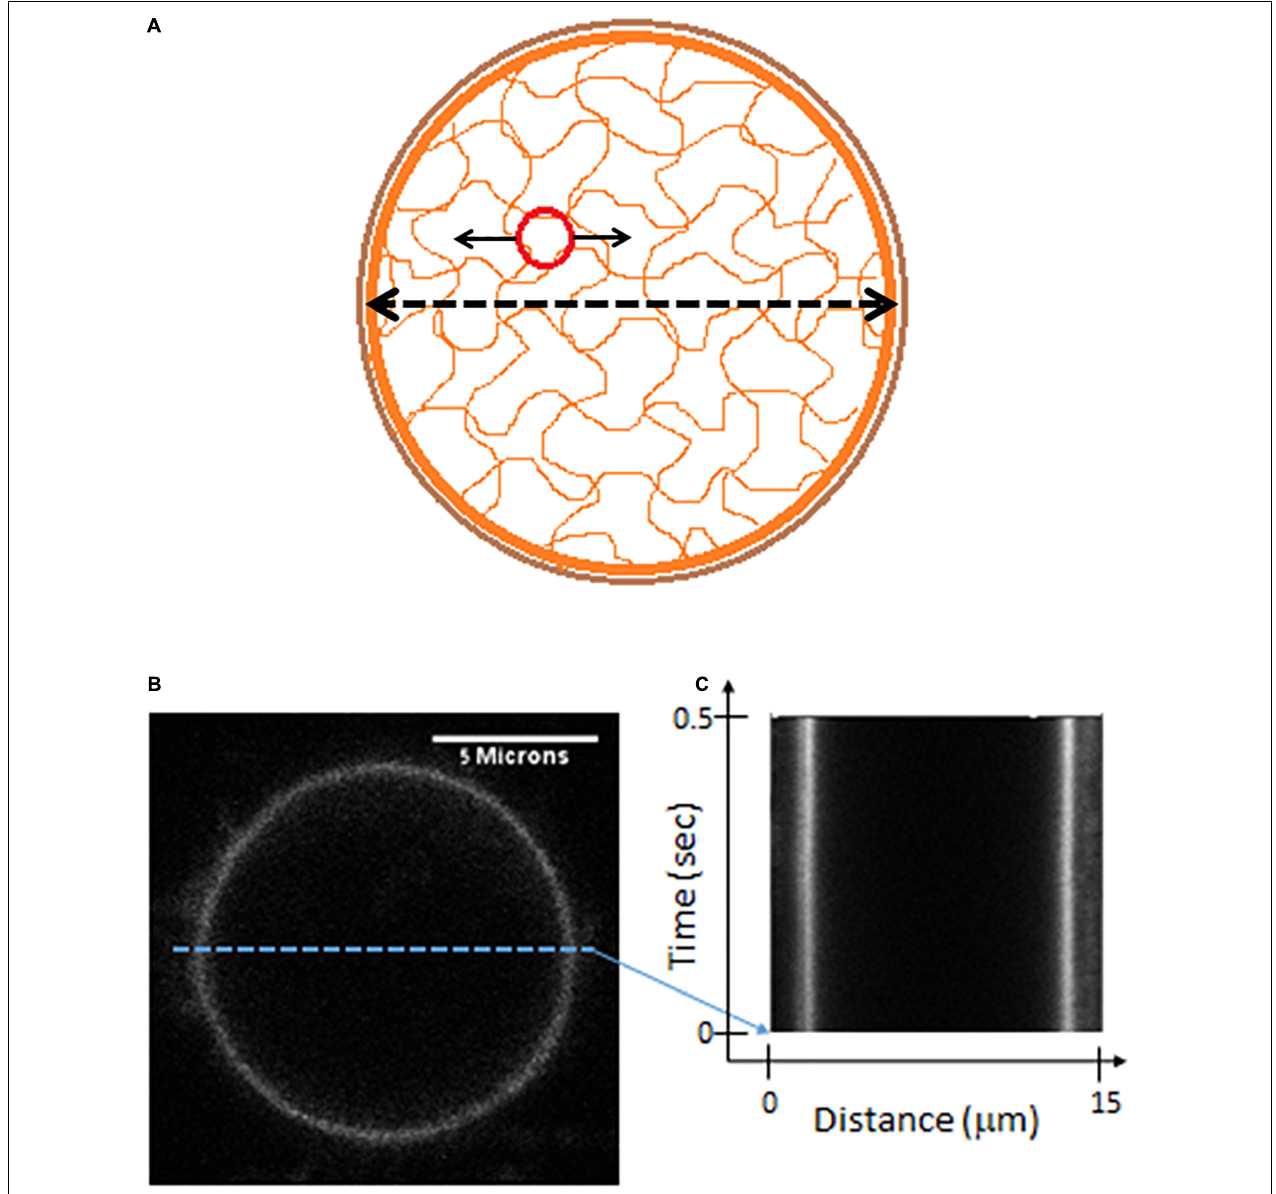
FIGURE 6 | Live cells Measurements of cell diameter fluctuations. (A) A scheme of the cell showing mechanical relations of its constituents. The possible mechanical relation between intracellular cytoskeleton fluctuations (that may be detected by the motion of imbedded particles) and the fluctuations of cytoskeleton borders or the cortical actin (that may be detected by following changes in cell diameter). (B) Confocal imaging of a live Jurkat cells, stained with CD45. (C) A kymograph showing fast (2 ms) and repetitive line-scans across the cell membrane at its apparent mid-section, as shown in panel (B)